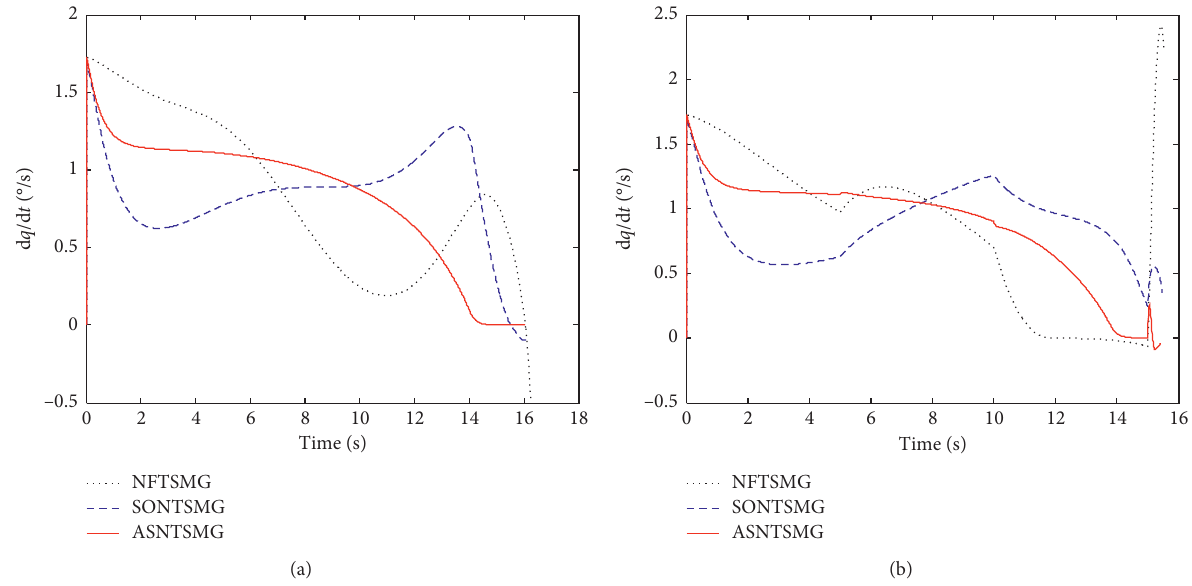
Figure 5: LOS angular rate. (a) Target cosine motion. (b) Target square wave motion.